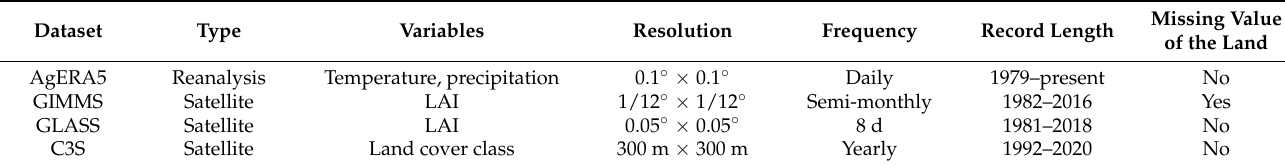
Table 1. Data used in this